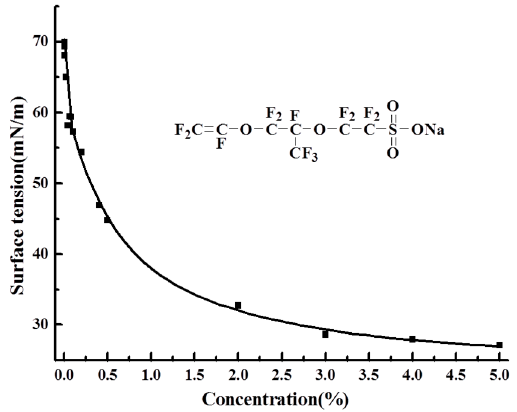
Figure 4. DSC curves of PSVNa.